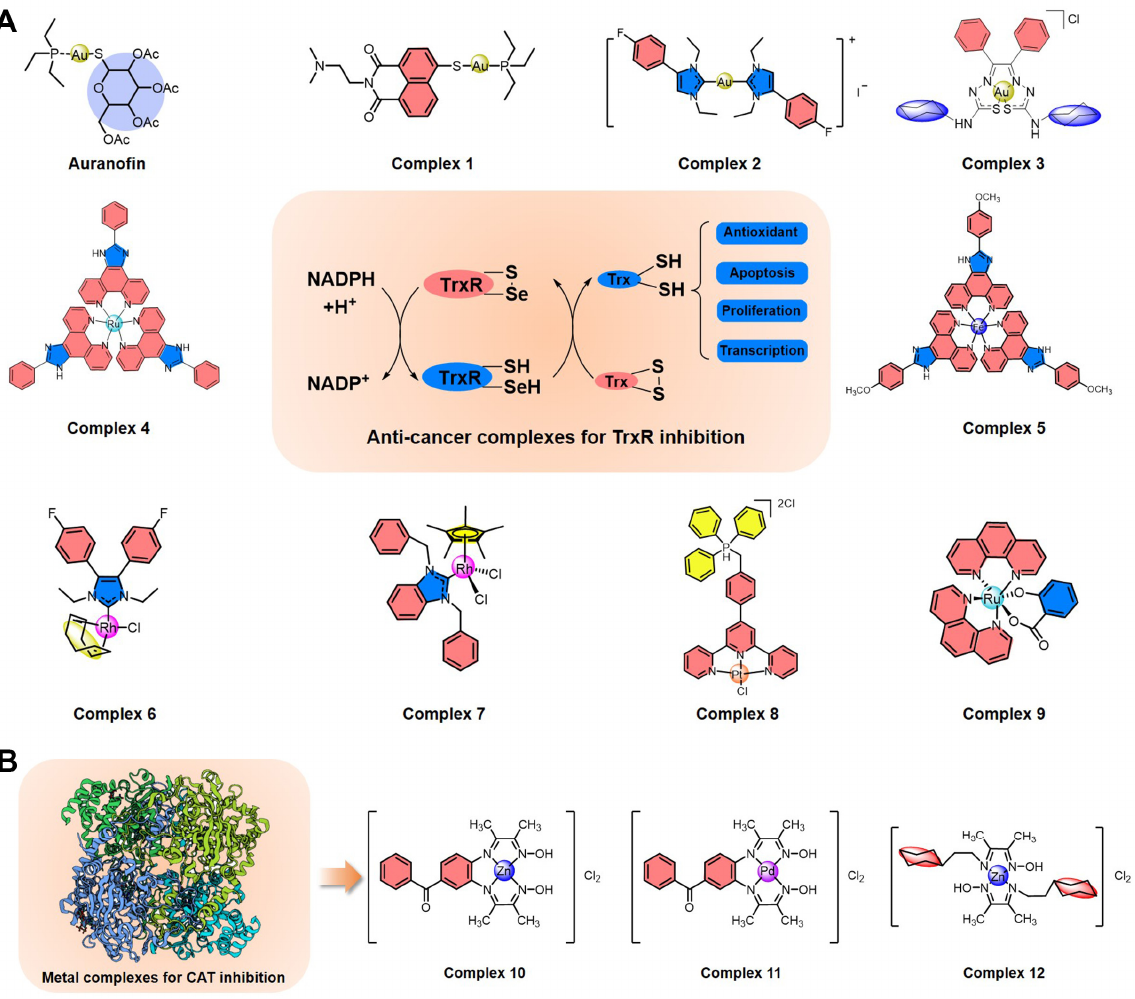
Figure 3. Summary of metal complexes inhibiting TrxR and CAT. ( A ) Structures of anti-cancer metal complexes for TrxR inhibition to regulate intracellular ROS levels. ( B ) Structures of metal complexes for CAT inhibition.